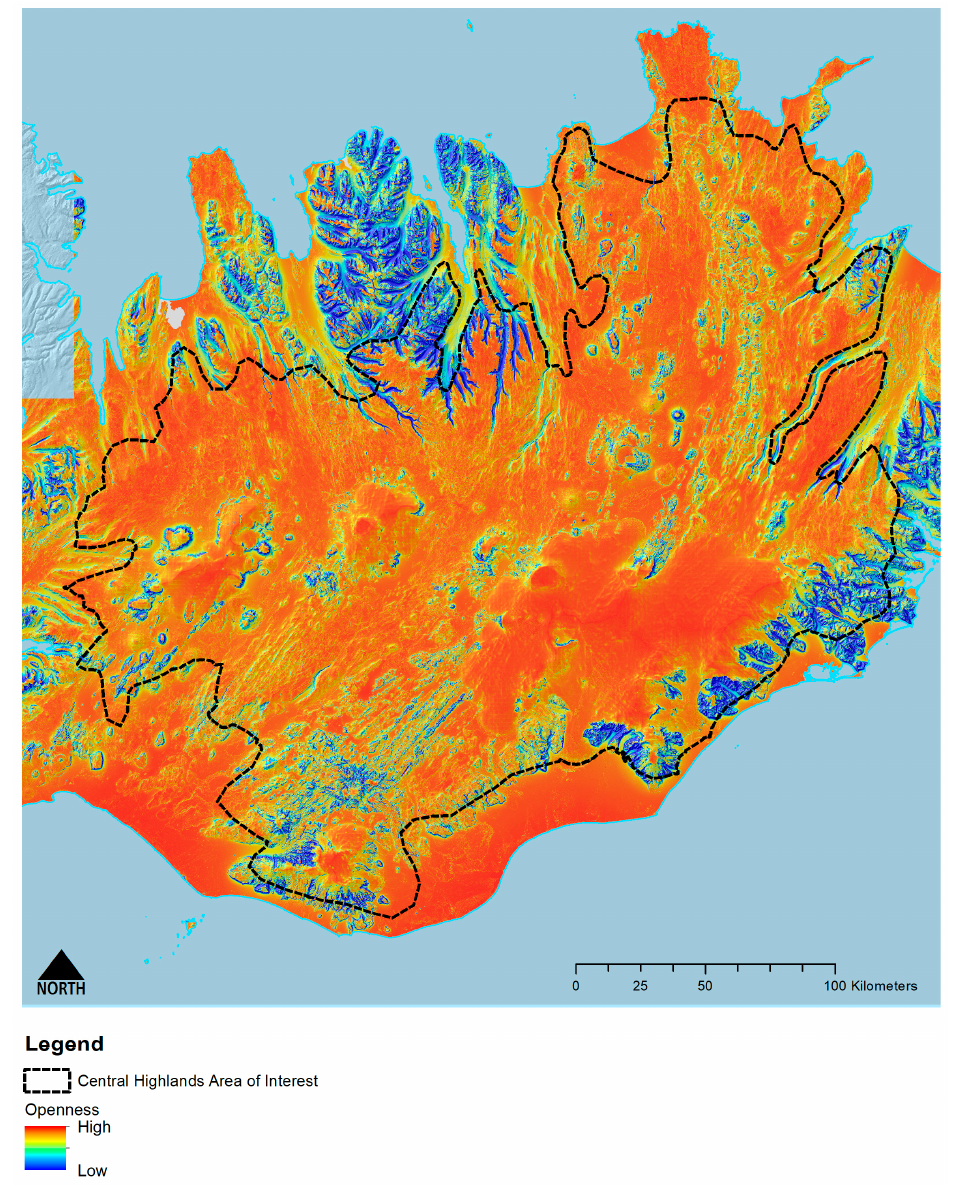
Figure 9. Obtained values for Openness for the Central Highlands. Table 3. Wilderness character summary